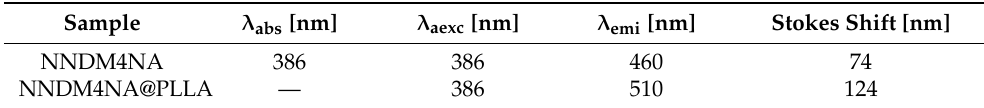
Table 1. Absorption and emission data for NNDM4NA in an ethanol solution at 1.0 × 10 − 4 M con- centration and embedded in polymer fibers.